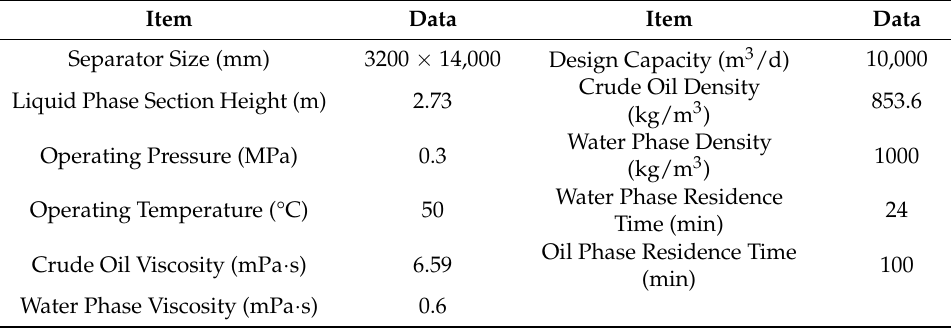
Table 1. Separator and physical parameters of crude oil.